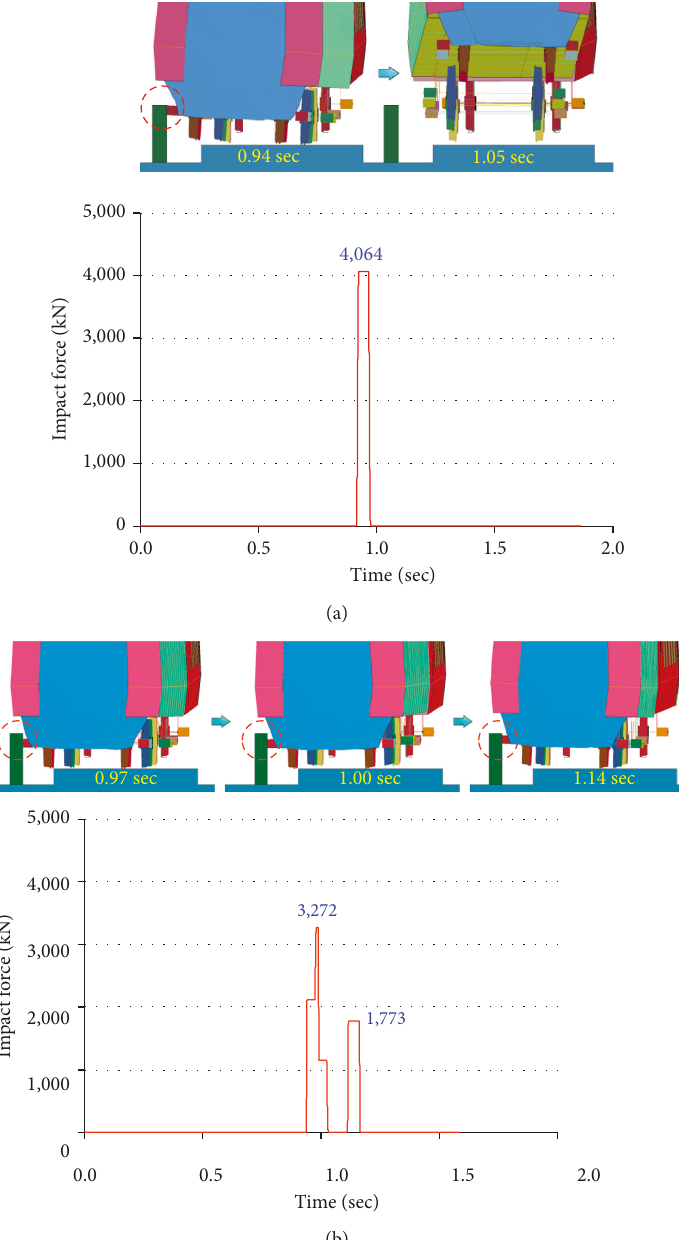
Figure 17: Derailment-collision behavior and impact force (height effect 1). (a) Derailment-collision behavior 1. (b) Derailment-collision behavior 2.